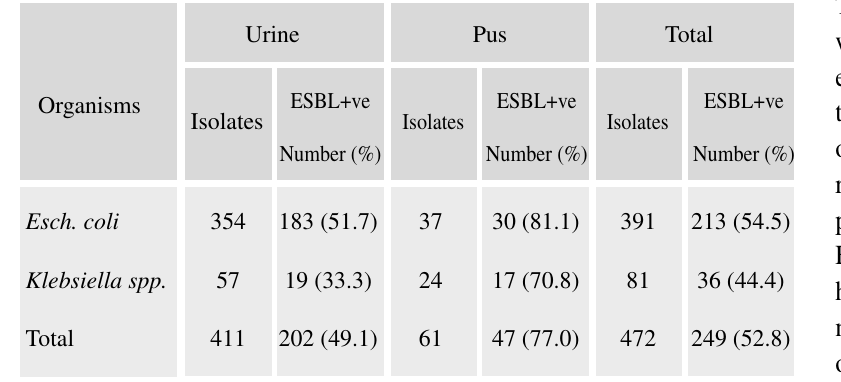
Table II: Frequency of ESBL positive Esch. coli and Klebseilla spp. in different specimens (N= 472)